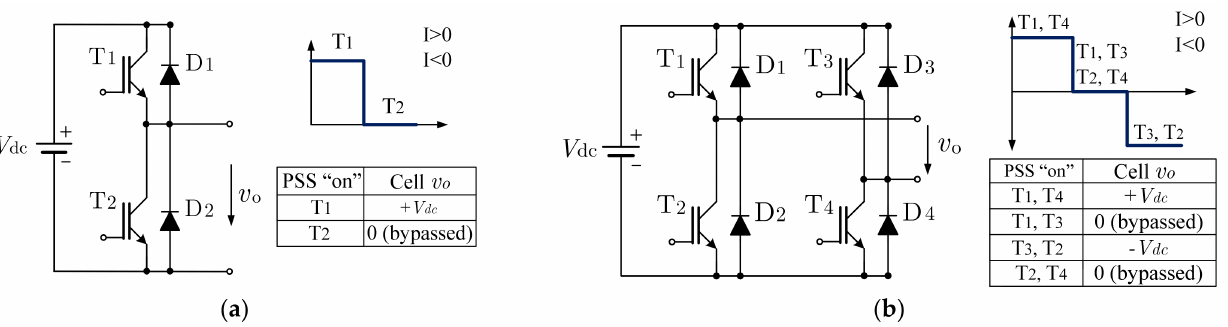
Figure 1. The most common power cells and their voltage levels: ( a ) HB cell; ( b ) FB